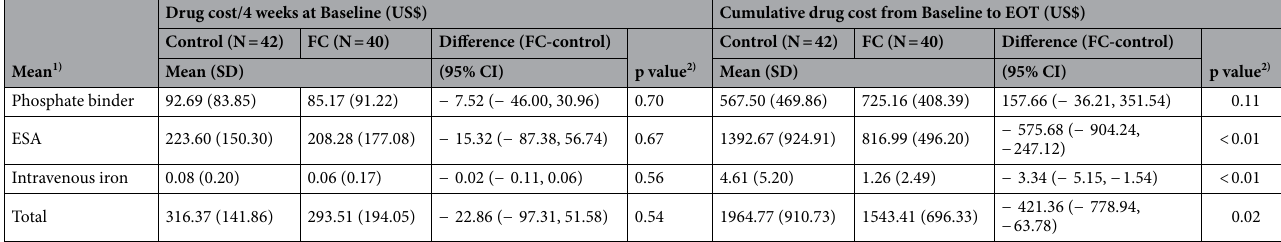
Table 3. Cumulative drug cost from baseline to the end of treatment (EOT). 1) Mean drug prices were used to calculate the drug cost for Calcium carbonate and Epoetin alpha. 2) Student’s t